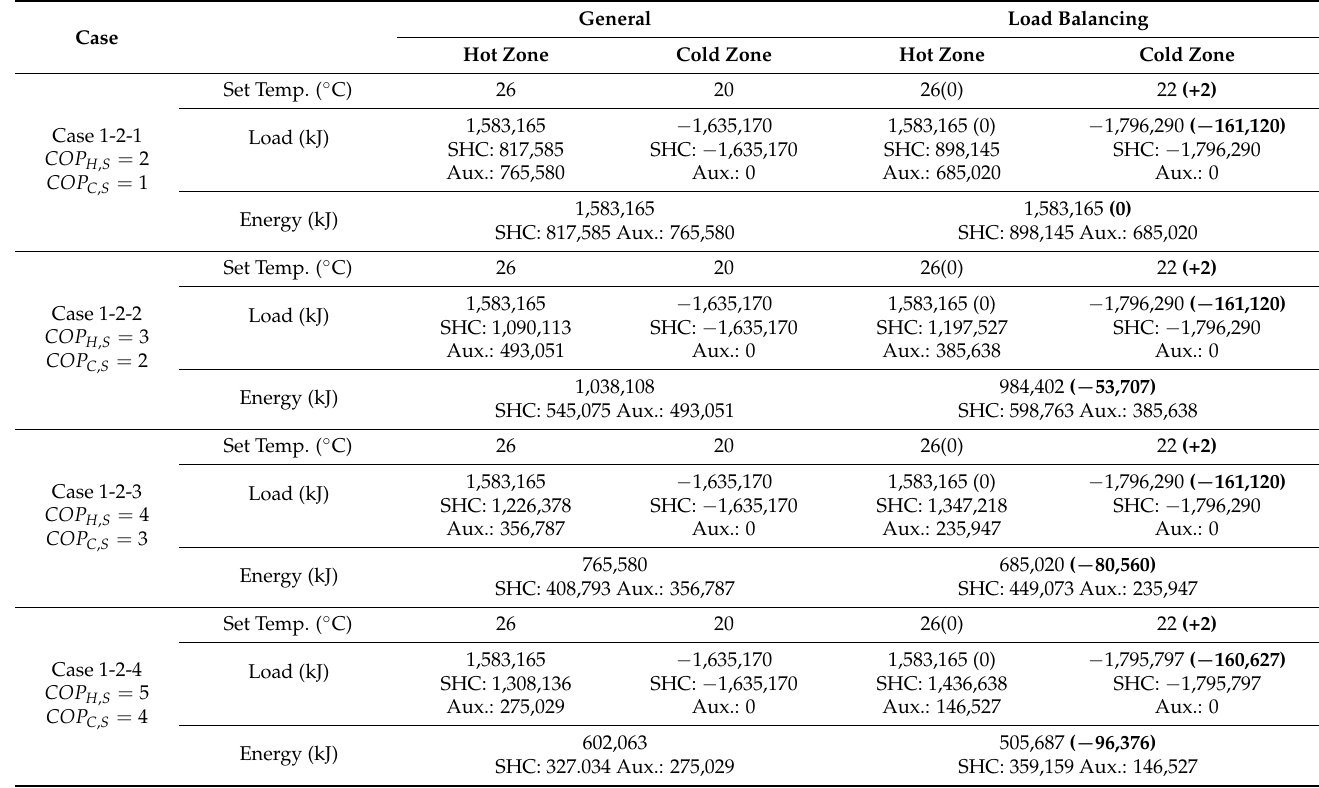
Table 7. Removed load and energy consumption (Cases 1 − 2-1~1 −